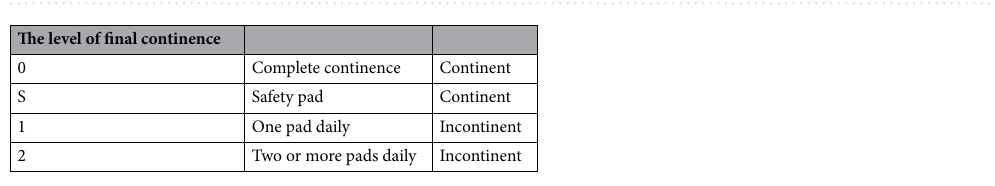
Table 1. Levels of final continence after